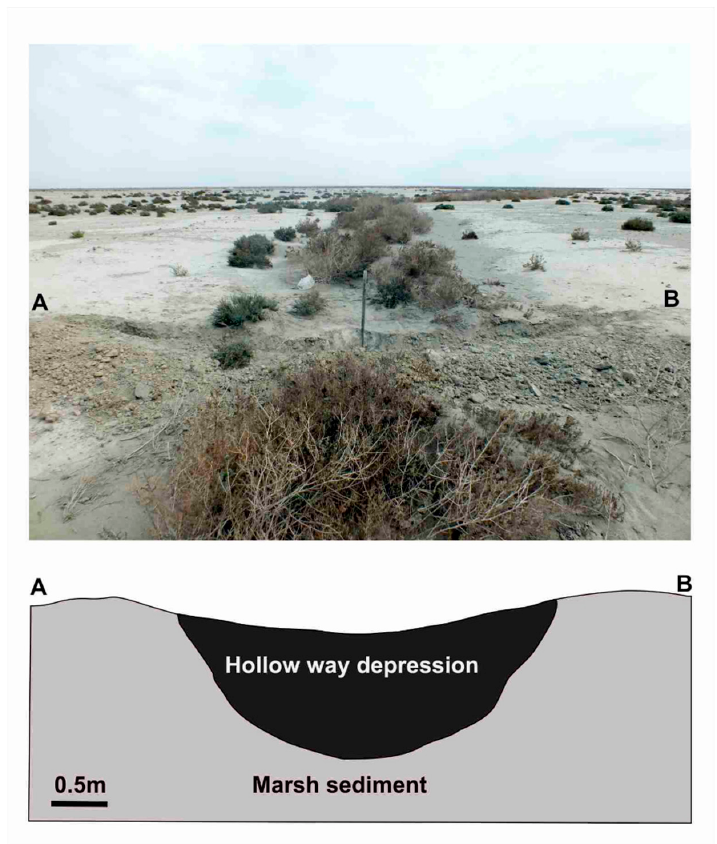
Figure 4. The cross-section of a hollow way. In Southern Mesopotamia, hollow ways can be distinguished from water channels by their relatively shallow depth and lack of meters-high levees.